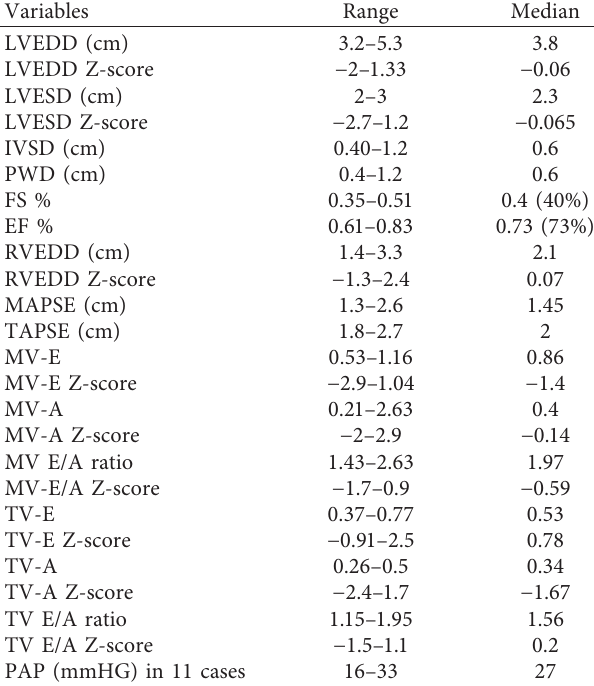
Table 3: Description of 2D echo, M-mode, PW, and CW mea- surements and Z-score among the study group.